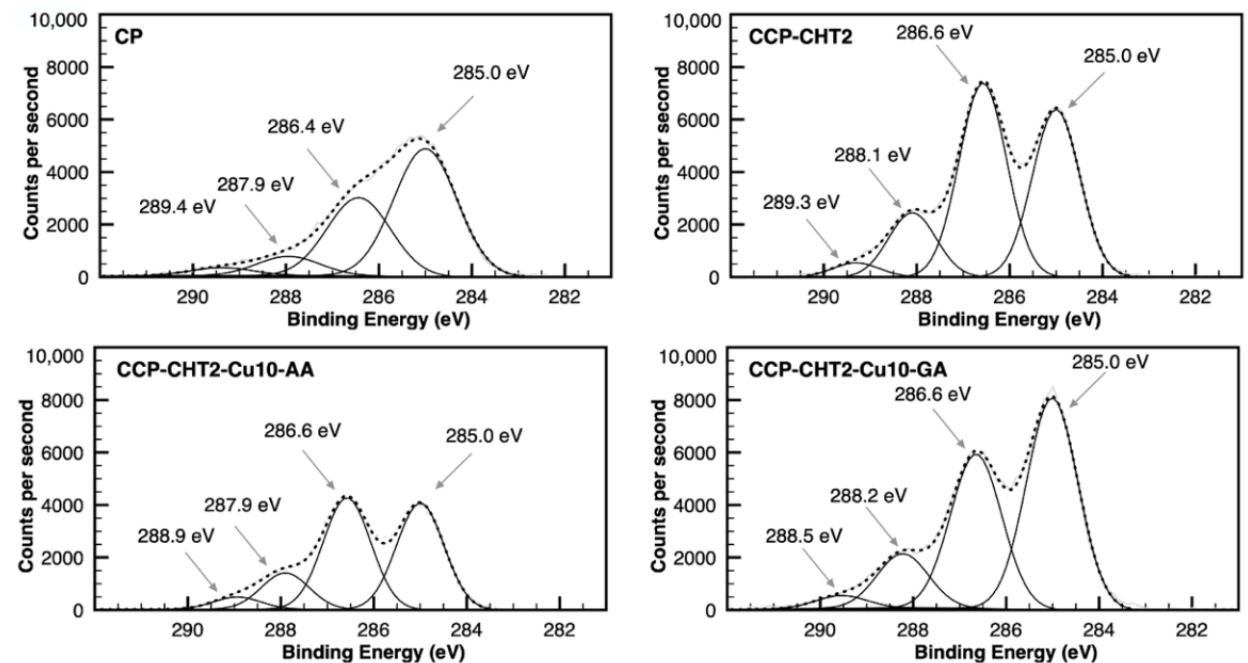
Figure 6. Gaussian deconvolution of high-resolution XPS C 1s spectra for CP, CCP-CHT2, CCP-CHT2-Cu10-AA, and CCP-CHT2-Cu10-GA samples.